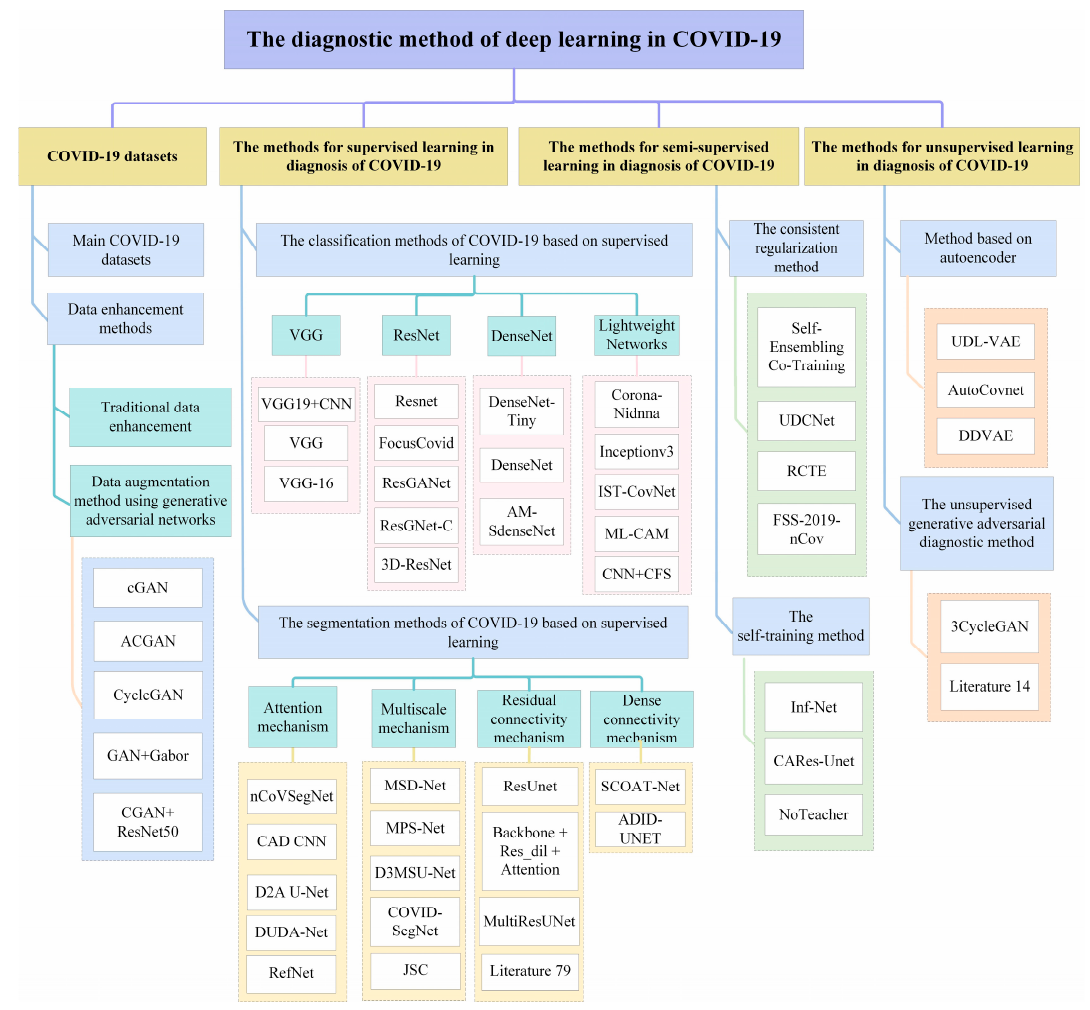
Figure 3. General architecture of deep learning COVID-19 images diagnosis method.